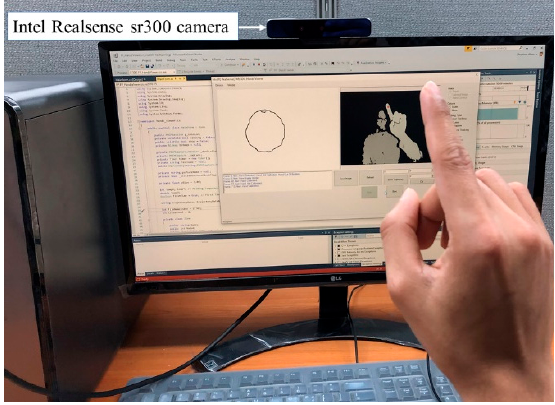
Figure 8. Experimental setup for air-writing dataset collection interface.